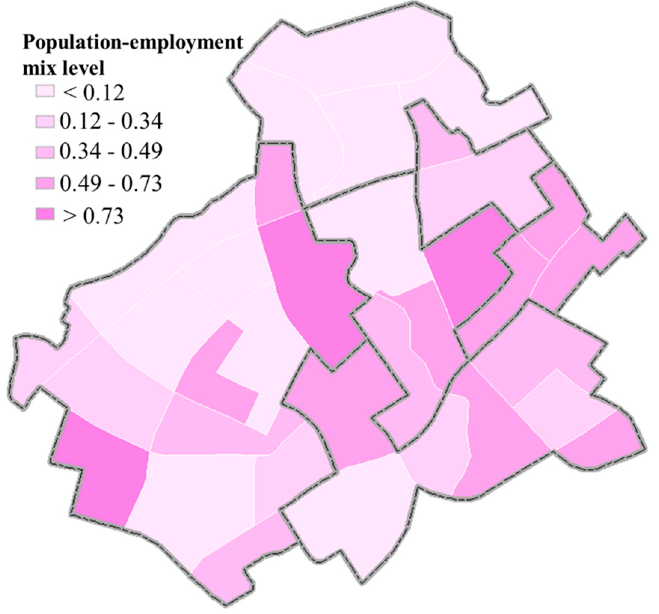
Figure 8. Spatial distribution of the population-employment mix level of each TAZ.